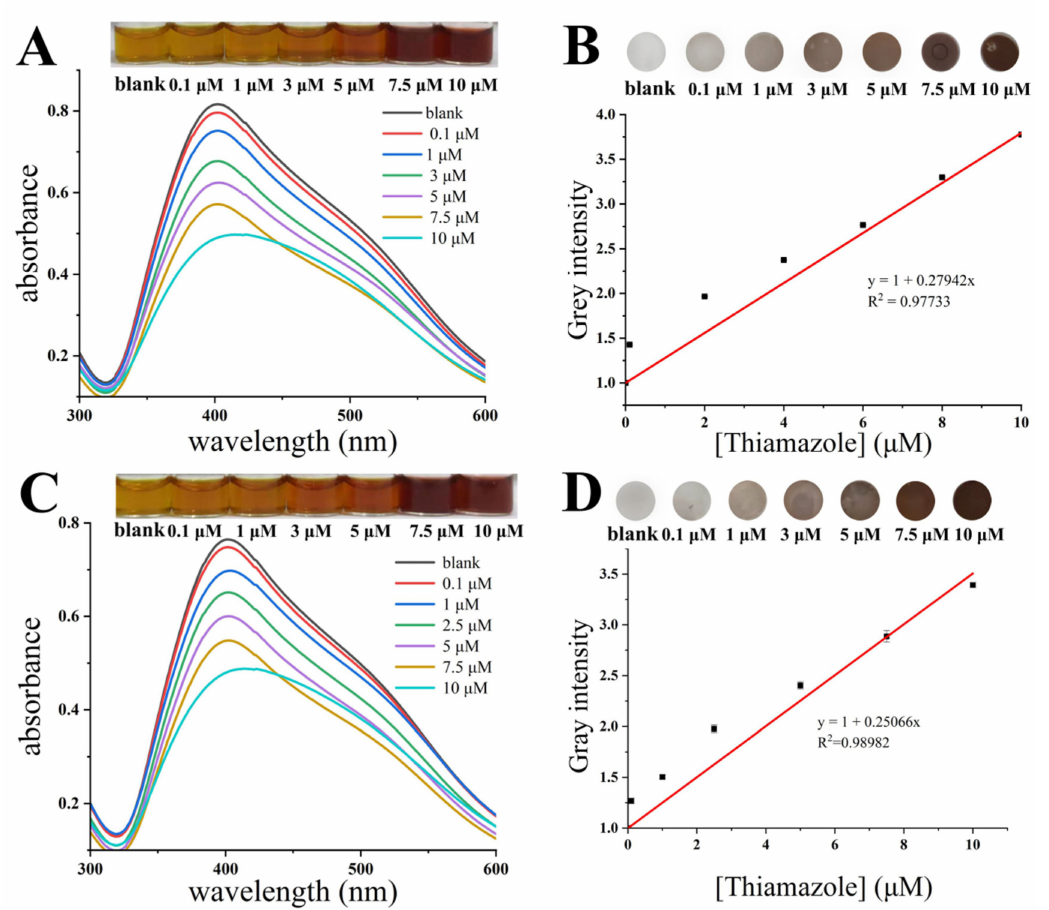
Figure 7. HPS-AgNPs detection of methimazole in ( A ) serum samples and ( B ) urine samples result in photos and UV spectra. Syringe paper-based detection device for methimazole in ( C ) serum samples and ( D ) urine samples result in photos and standard curves.